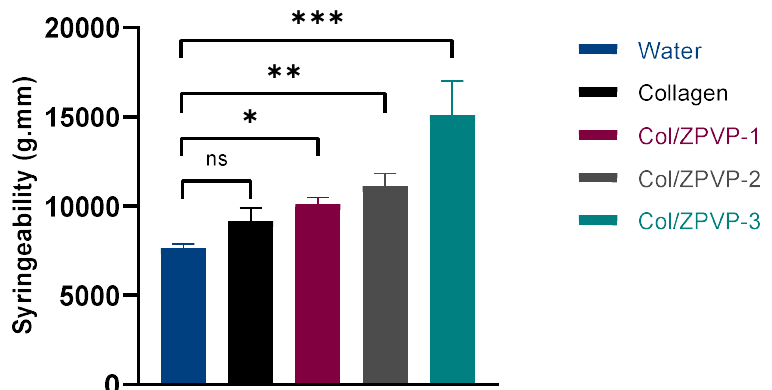
Figure 3. Syringeability of pre-filled syringes of collagen, Col/ZPVP-1, Col/ZPVP-2, Col/ZPVP-3, and water at room temperature. Error bars represent SD; n = 3; ns = non-significant ( p > 0.05) ; * p ≤ 0.05; ** p ≤ 0.01; *** p ≤ 0.001.